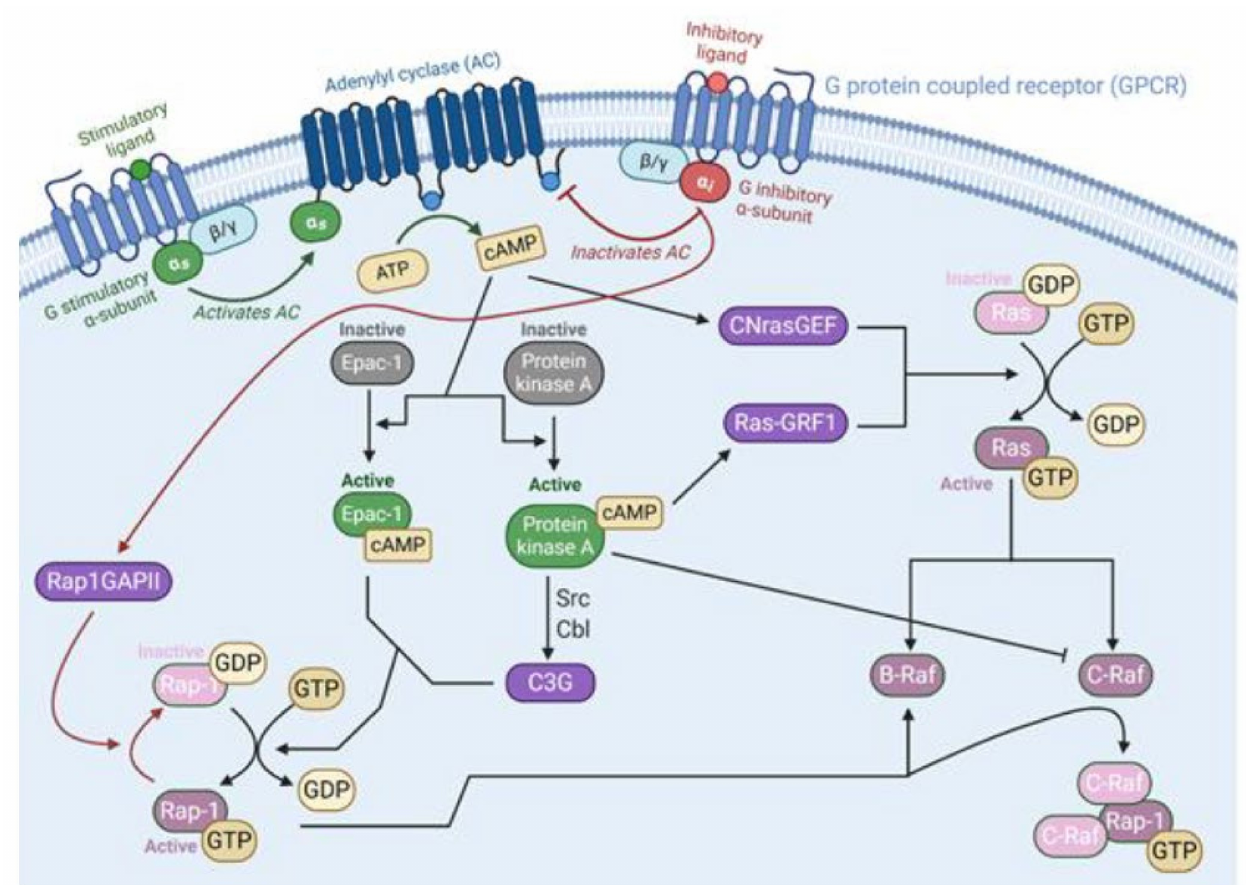
Figure 5. G-protein-coupled receptor subunits G α s and G α i interaction with the Ras-Raf pathway. When activated by a ligand, the GPCR is induced to exchange its bound GDP for GTP, freeing the α subunit to act on the cell. α s acts on adenylyl cyclase (AC) to increase the production of the second messenger cAMP from ATP [120]. In turn, cAMP activates Epac-1 [121] and protein kinase A [120]. Epac-1 and C3G, a downstream molecule from PKA, are guanine-nucleotide exchange factors for Rap-1 and induce the exchange of GDP to GTP to activate it [121,122]. Both activate Rap-1, which can modulate the activity of BRaf [115]. Protein kinase A has other mechanisms of action as well. It can directly prevent the activation of CRaf through phosphorylation [123]. It also activates a Ras GEF, RasGRF1, to start the MAPK cascade in certain cells [124]. In contrast, α i inhibits adenylyl cyclase and produces opposite effects.